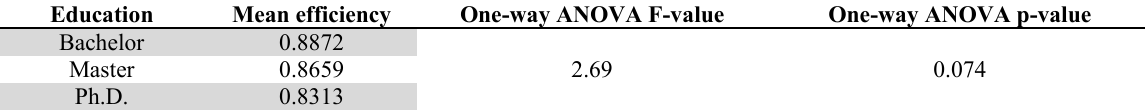
The impact of education on the development of trust in the distribution companies’ model